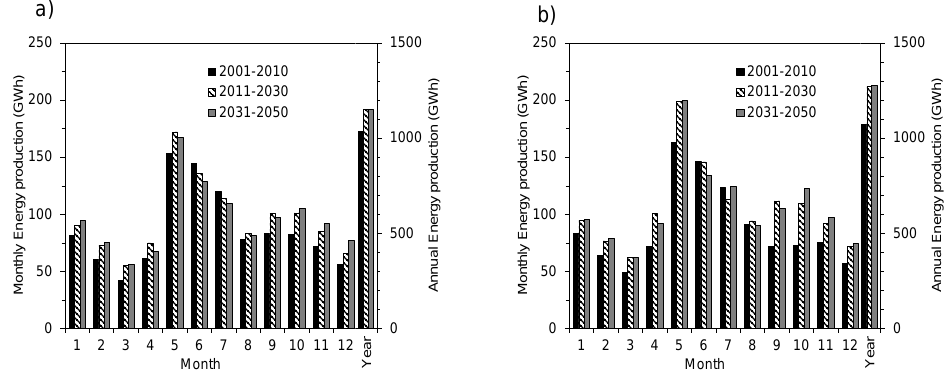
Figure 7. Average monthly and annual total hydropower production evaluated by the hydropower simulation model using the discharge dataset built starting from ( a ) REMO and ( b ) RegCM3 climatic scenarios.